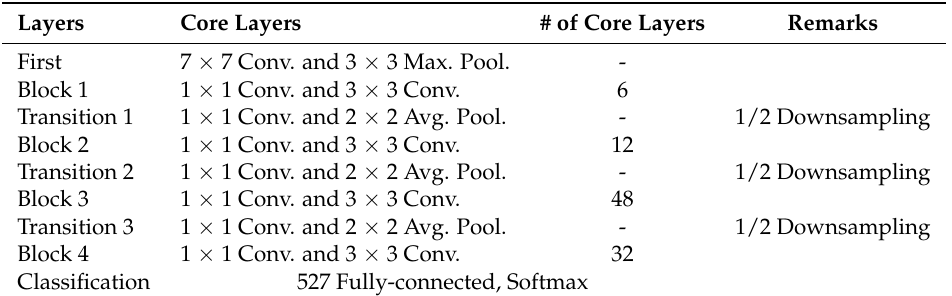
Table 2. The structure of modified DenseNet-201 model for Caoshu recognition.